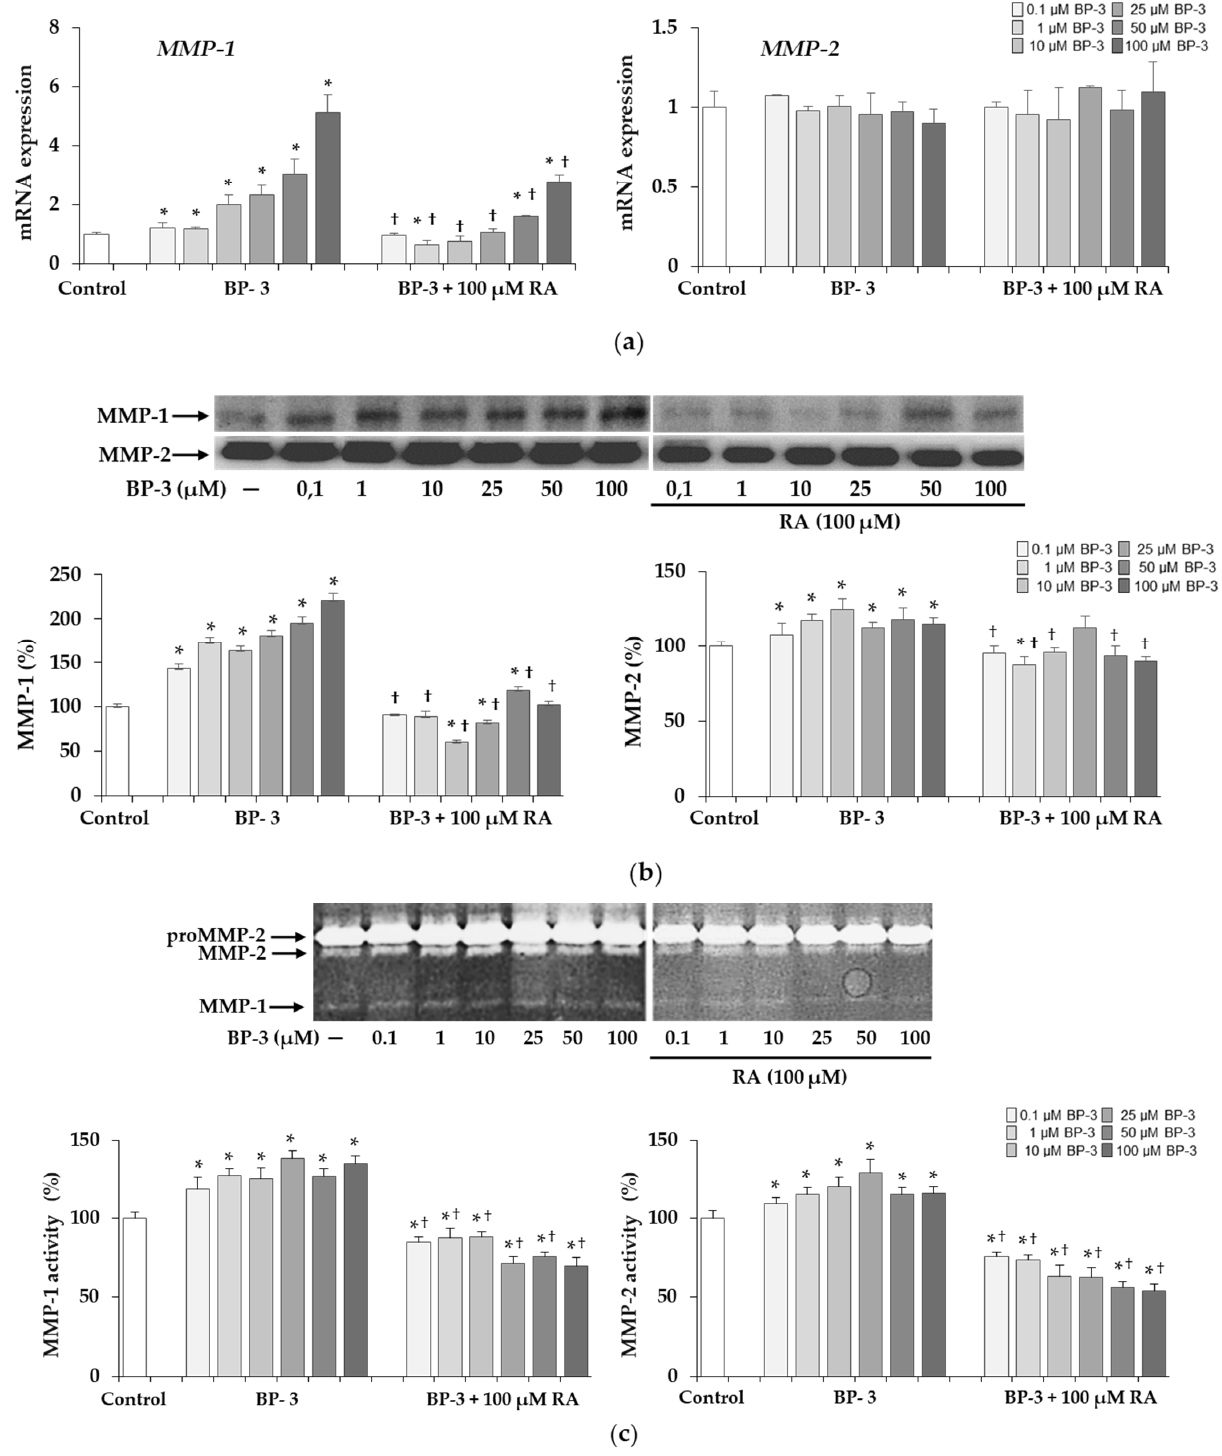
Figure 10. The influence of benzophenone-3 (BP-3) alone and in combination with rosmarinic acid (RA) on the expression of matrix metalloproteinases (MMP-1 and MMP-2) at the mRNA ( a ) and protein ( b ) levels and their activity ( c ) in fibroblasts. The expression of MMP ( MMP-1 and MMP-2 genes was assayed by real-time PCR, values represent the mean ± SD of three experiments ( a ). Representative gels of Western blotting ( b ) and zymography ( c ); densitometry values represent the mean ± SD of three experiments. The data are expressed as a percentage of the control sample assumed as 100% ( b , c) ; * p < 0.05 vs. control (untreated cells); † p < 0.05 vs. respective samples treated with BP-3 alone.